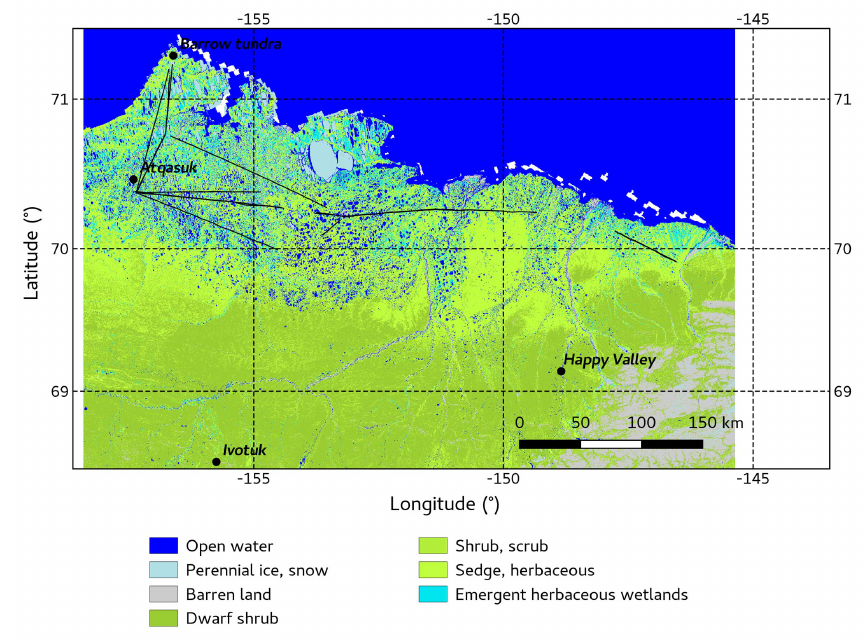
Figure 9. Land cover classes according to the National Land Cover Database, 2011. Black lines represent Polar 5 flight lines. Table 4. Relative coverage for each land cover class and median, maximum, 25% percentile, and 75% percentile of energy fluxes for different NLCD land cover classes, calculated from the ensemble flux maps shown in Fig. 8.